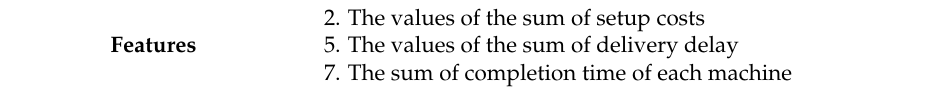
Figure 7. Weighting factor is ( w 1 , w 2 ) = (0.9, 0.1). Table 12. List of features selected by SFS.